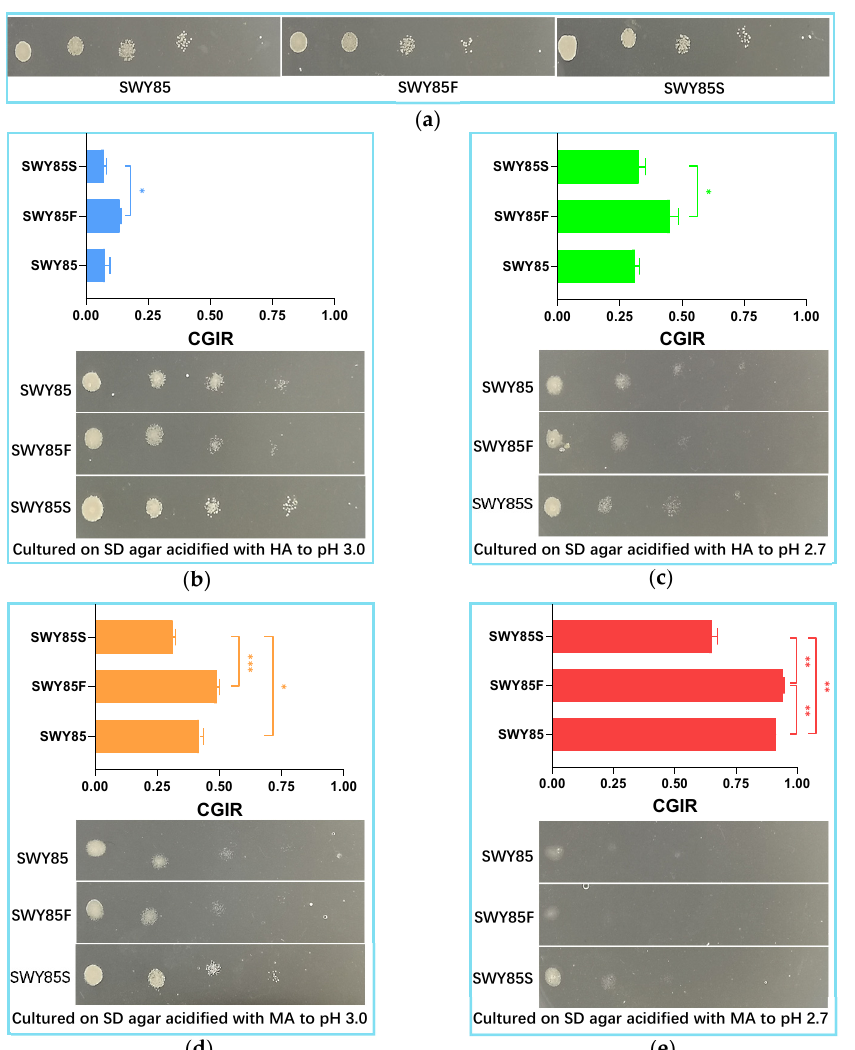
Figure 2. The inhibitory effect of malic acid stress on cell growth of the three strains under amino acid starvation. The growth status of the strains on SD agar at natural pH ( a ), and the colonies formed on acidified SD agar and the cell growth inhibitory rates (CGIR) of the three strains cultured with amino acid starvation under acidification with hydrochloric acid to pH 3.0 ( b ) and pH 2.7 ( c ), respectively, and under acidification with malic acid to pH 3.0 ( d ) and pH 2.7 ( e ), respectively. HA, Hydrochloric acid; MA, Malic acid. * p < 0.05, ** p < 0.01, *** p < 0.001.